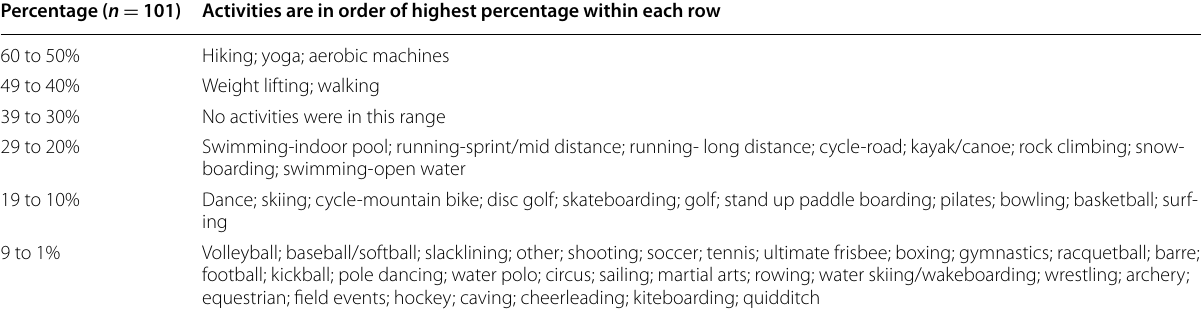
Table 1 Percent of participants reporting cannabis use by activity a